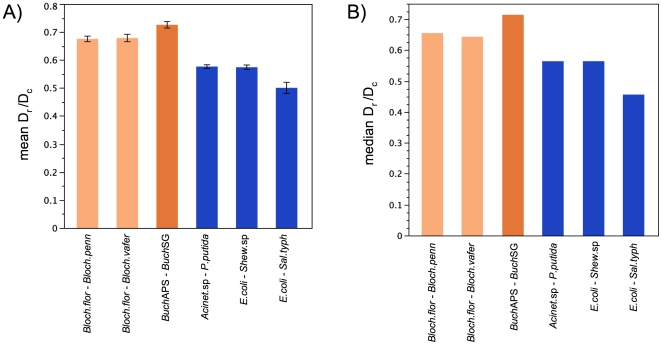
Empirical data: The two endosymbiont groups show a significant elevation in Dr/Dc, consistent with lower selective constraint in their small populations.Among 256 orthologs shared across all six genome pairs, (a) mean values (with bars showing standard error) and (b) median values of Dr/Dc were substantially higher within pairs of endosymbionts (orange) than free-living species (blue). This elevation of Dr/Dc was significant by a sign test and Wilcoxon test (see text and Table 6). Dr/Dc was calculated under the classification scheme of Miyata et al. [56]. A less stringent filter was used for E. coli-S. typhimurium, in order to retain a comparable number of genes for pair. For this pair, the 221 genes analyzed consisted of the 256 orthologs surviving the “high s.e. filter” (see text) in the five other genome pairs, minus 35 genes that contain zero radical and/or conservative substitutions between E. coli and S. typhimurium.